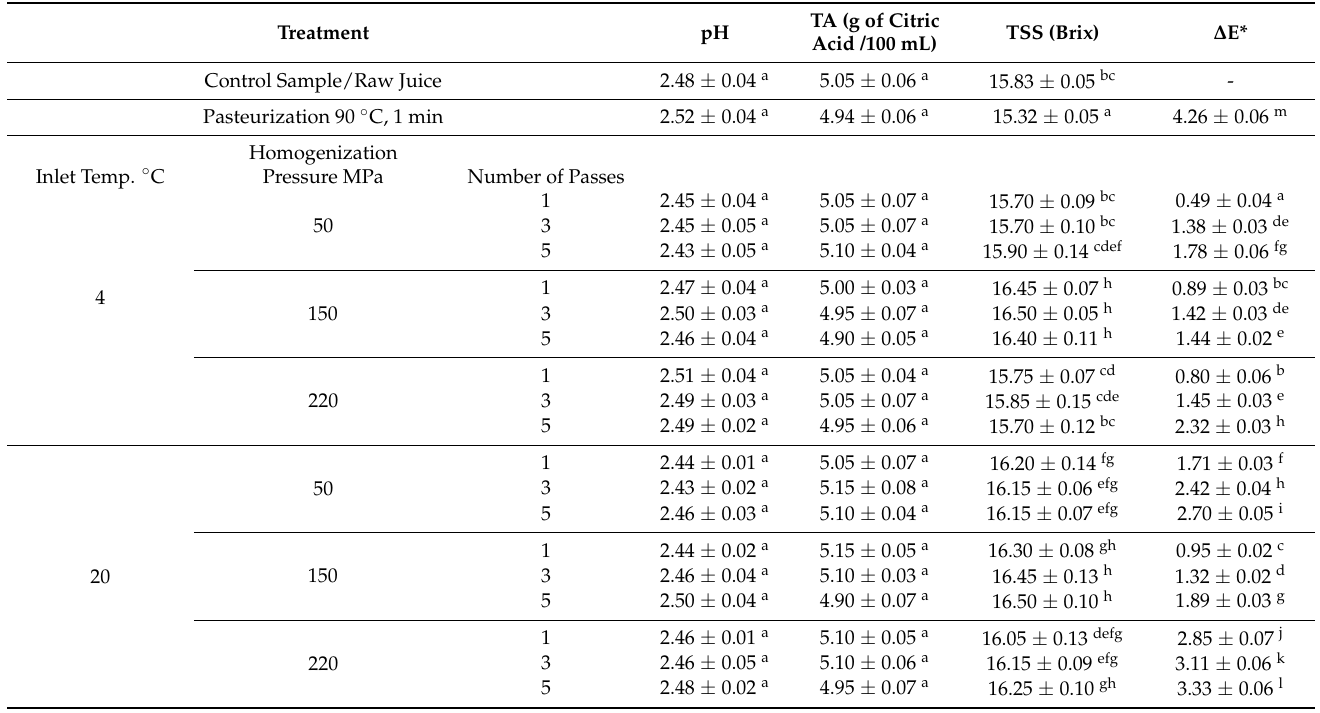
Table 1. The physicochemical characteristics: pH, titratable acidity (TA), total soluble solids (TSS), and the total colour difference ( ∆ E*) of cloudy blackcurrant juice treated with high-pressure homogenization or pasteurization.